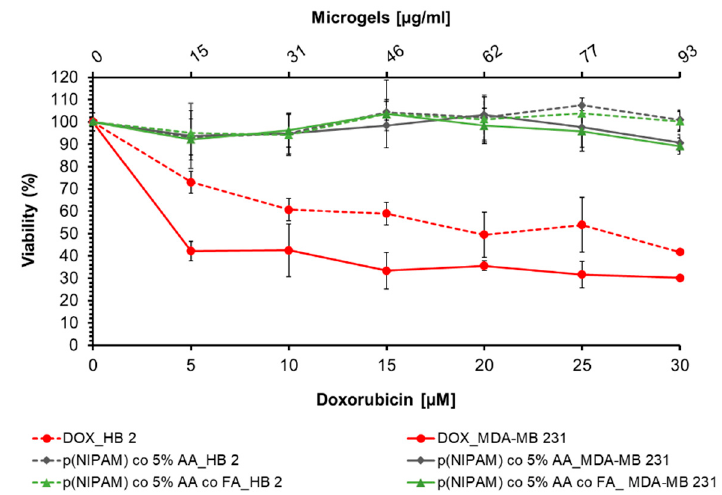
Figure 7. Viability assay on HB2 and MDA-MB 231 cells incubated for 24 h with p(NIPAM)-co-5%AA, p(NIPAM)-co-5%AA-co-FA (5; 10; 15; 20; 25; 30 µg/mL). Cells treated with doxorubicin were used as positive control, while untreated cells were used as negative control.